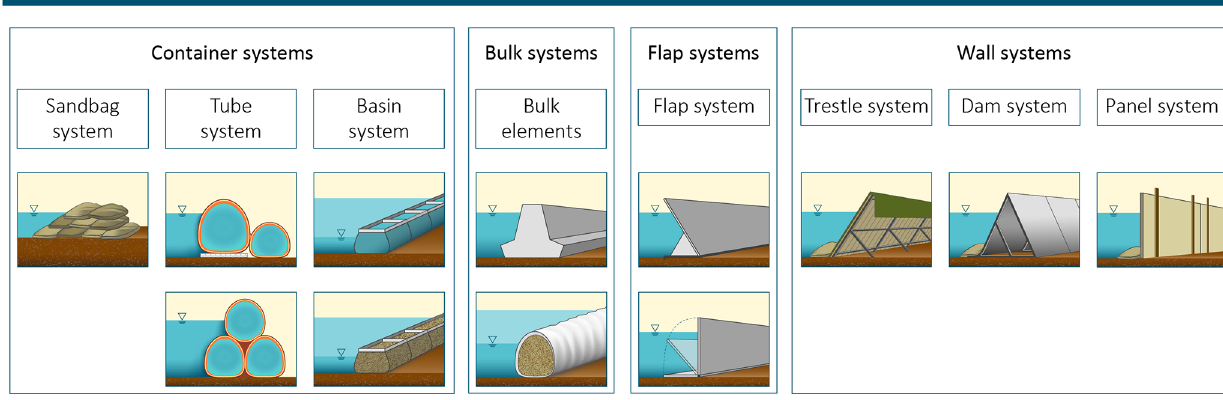
Figure 1. Classification of mobile, location-independent flood protection systems (Massolle et al., 2018).